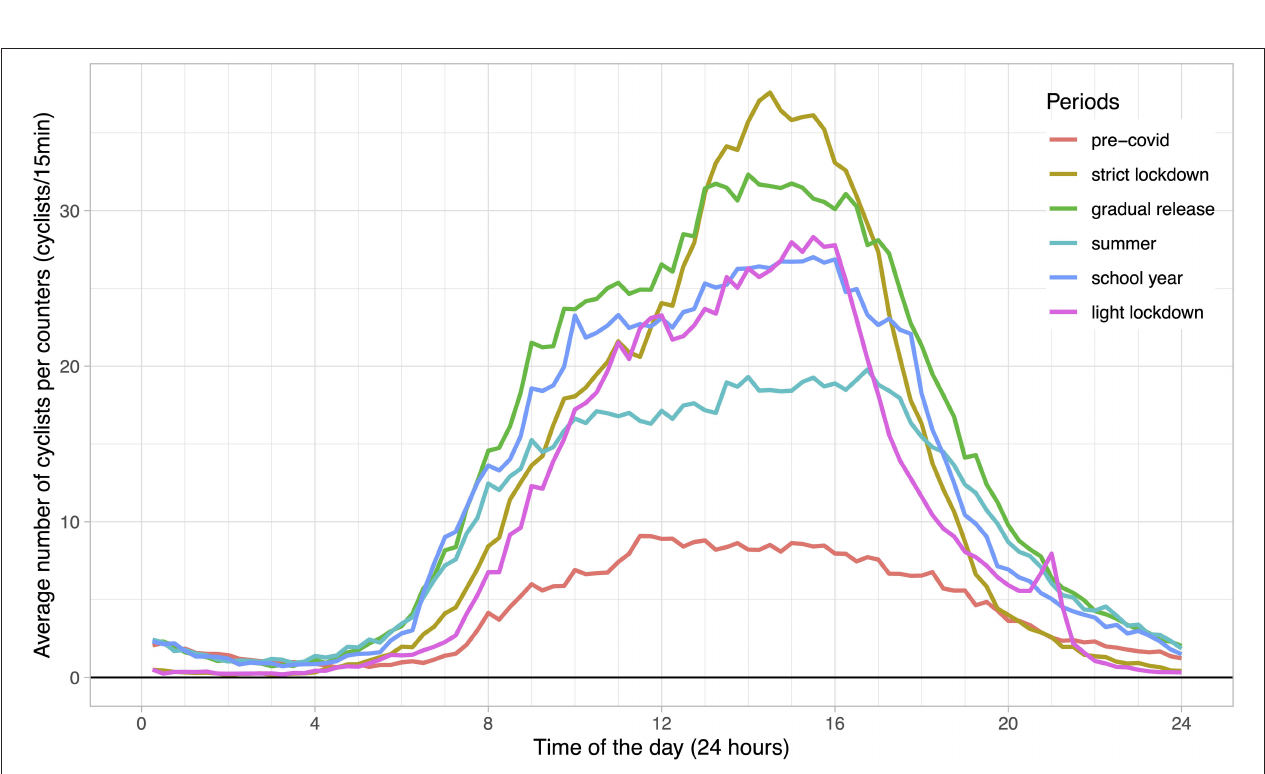
FIGURE 8 | Average bicycle levels per counter during the weekend and across the day for each of the six periods (data source: Brussels Mobility).